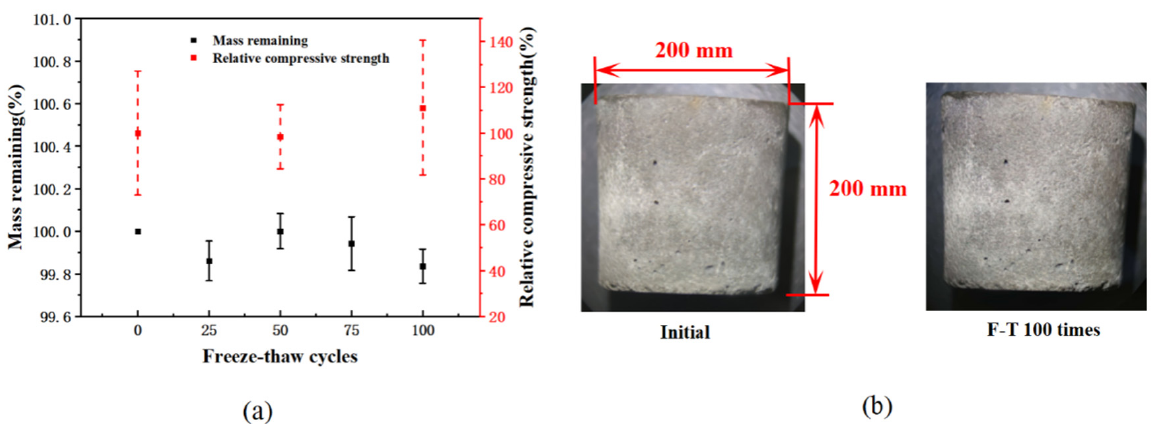
Figure 4. Changes of cement paste under freeze-thaw cycles ( a ) changes in quality and strength; ( b ) changes in morphology.